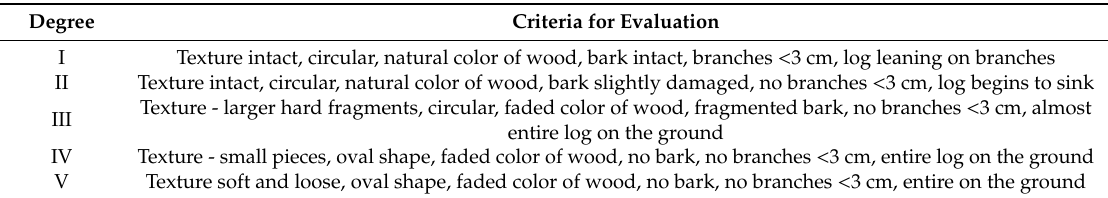
Table 1. Decay class characteristics by Maser et al. (1979).